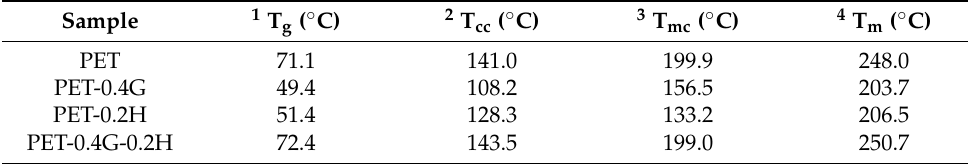
Table 1. DSC data of neat PET and its composites.